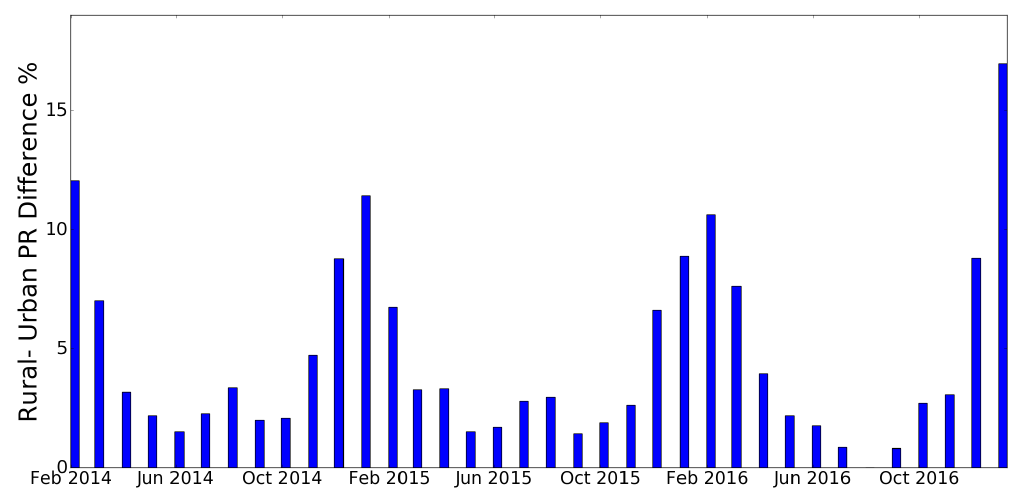
Figure 6. Monthly PR difference between PV installations in rural and urban